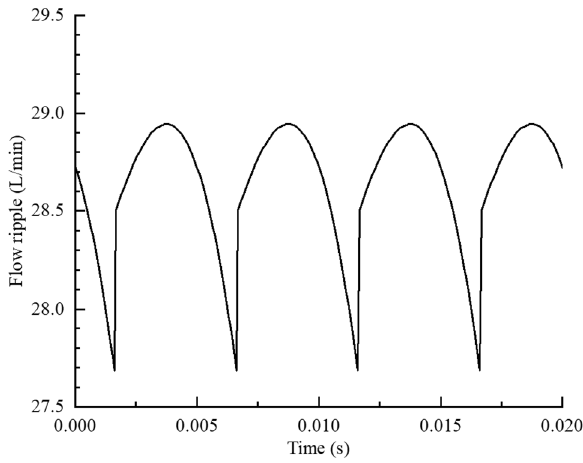
Figure 7. Theoretical flow ripple ( n = 1200